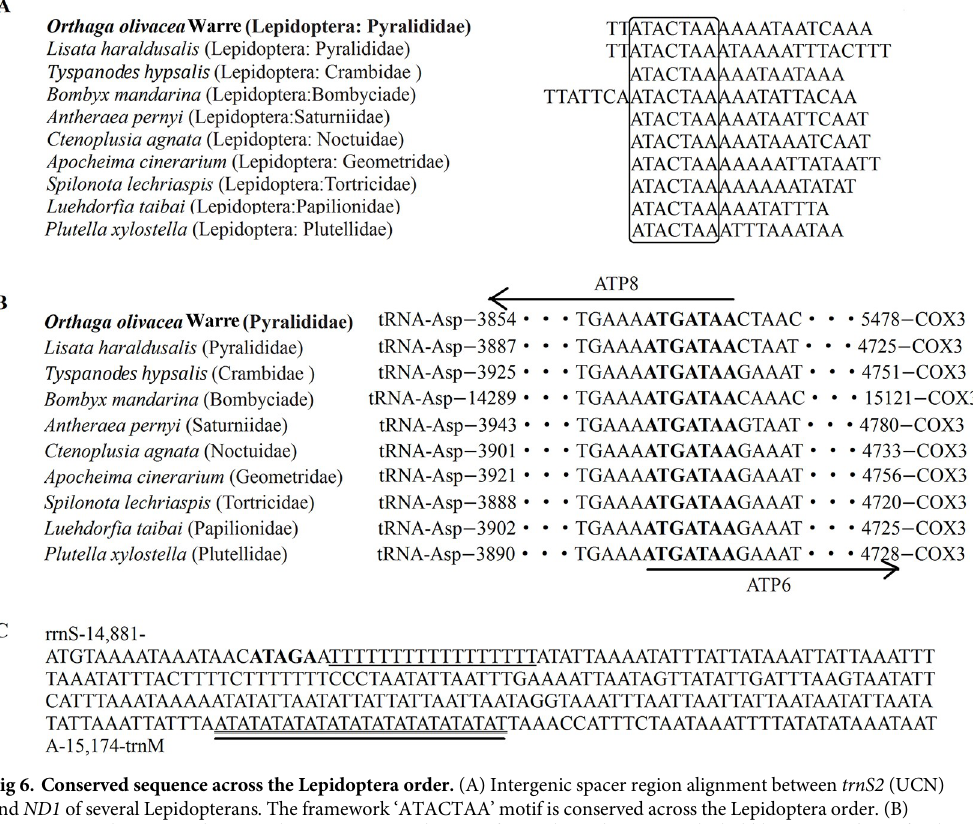
Fig 6. Conserved sequence across the Lepidoptera order. (A) Intergenic spacer region alignment between trnS2 (UCN) and ND1 of several Lepidopterans. The framework ‘ATACTAA’ motif is conserved across the Lepidoptera order. (B) Intergenic overlap region alignment between ATP8 and ATP 6 of several Lepidopterans. The bold ‘ATGATAA’ motif is the overlap region and it’s conserved across the Lepidoptera order. (C) Features present in the A+T-rich region of Orthaga olivacea Warre. The sequence is shown in the reverse strand. The ATAGA motif is bolded. The poly-T stretch is underlined. The single microsatellite T/A repeat sequence are double underlined.